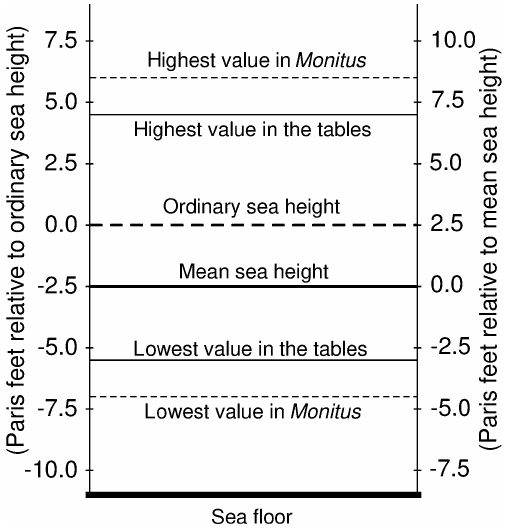
Figure 2. Scheme of the main levels reported by Vordoni measured relative to the ordinary sea height (left scale) and to the mean sea height (right scale). Monitus is the first page of the manuscript (see text for details; 1ft = 12in. = 32.4845cm; Martini,